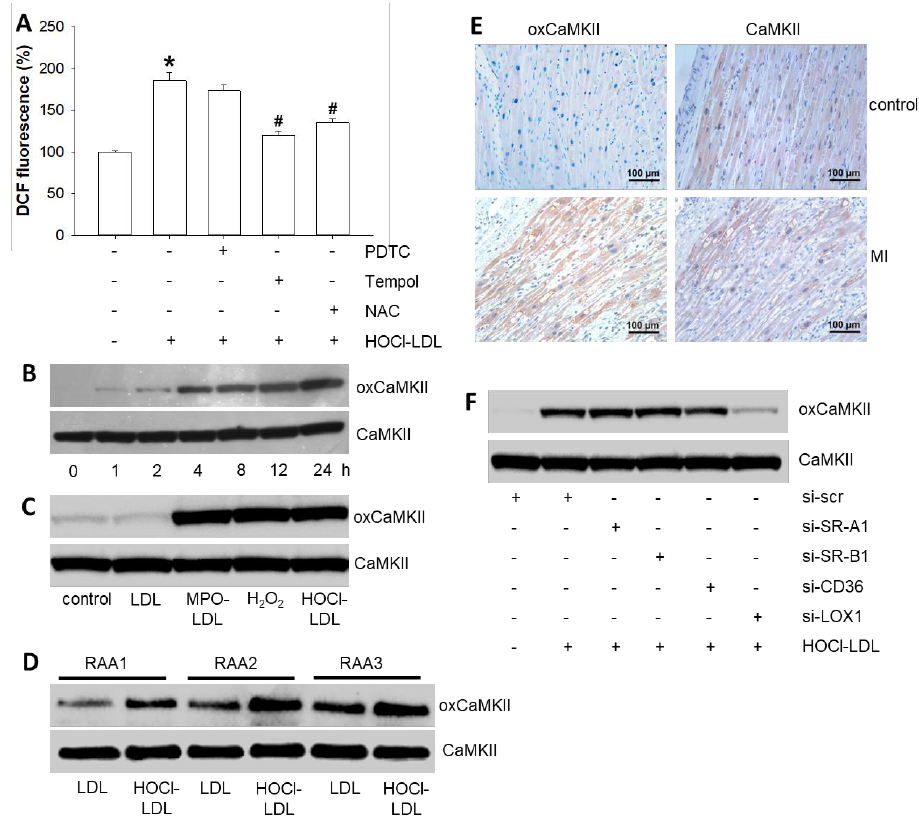
Figure 2. Induction of superoxide anions and LOX-1-mediated CaMKII oxidation by HOCl-LDL. ( A ) DCF fluorescence intensities in HL-1 cardiomyocytes incubated with HOCl-LDL (oxi- dant:lipoprotein molar ratio of 200:1, 250 µ g/mL, 1 h) with or without ROS/RNS scavengers (PDTC [1 mM], Tempol [1 mM], or NAC [5 mM], 30 min pre-treatment) ( n = 6). ( B ) Time-dependency of CaMKII oxidation in HL-1 cardiomyocytes treated with HOCl-LDL (oxidant:lipoprotein molar ratio of 200:1, 250 µ g/mL) for indicated time periods ( n = 6). ( C ) CaMKII oxidation in HL-1 cardiomyocytes incubated with native LDL (250 µ g/mL, 8 h), MPO-LDL (250 µ g/mL, 8 h), H 2 O 2 (100 µ M, 1 h), or HOCl-LDL (oxidant:lipoprotein molar ratio of 200:1, 250 µ g/mL, 8 h) ( n = 6). ( D ) oxCaMKII ex- pression in three human RAAs incubated with either native LDL or HOCl-LDL (oxidant:lipoprotein molar ratio of 200:1, 250 µ g/mL, 8 h) ( n = 3). I Representative immunostainings of oxCaMKII (red) and CaMKII (red) in healthy (control, upper panels) and infarcted border regions (MI, lower panels) of the myocardium. Cardiomyocyte nuclei were stained blue with hematoxylin. ( F ) HOCl-LDL (oxidant:lipoprotein molar ratio of 200:1, 250 µ g/mL, 8 h)-induced oxCaMKII expression in HL-1 car- diomyocytes transfected with scrambled siRNA (si-scr) (40 nM) or siRNA against SR-A1 (si-SR-A1), SR-B1 (si-SR-B1), CD36 (si-CD36), or LOX-1 (si-LOX-1) (40 nM) ( n = 6). Values are expressed as mean ± SEM. ( n ) represents the number of experiments. * indicates p < 0.05 vs. control and # indicates p < 0.05 vs.